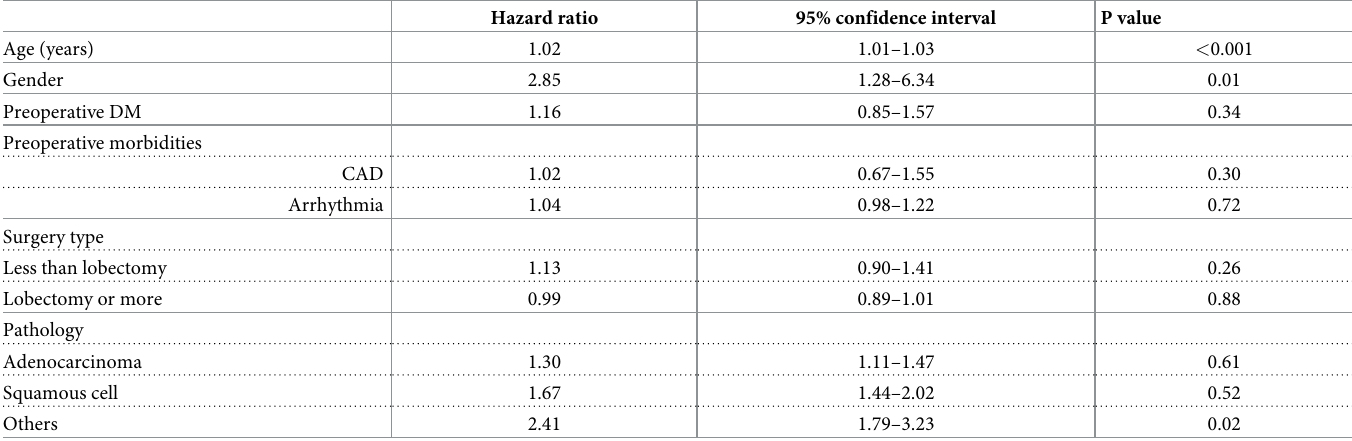
Table 4. Multivariate Cox regression of survivals in patients of resected NSCLC.